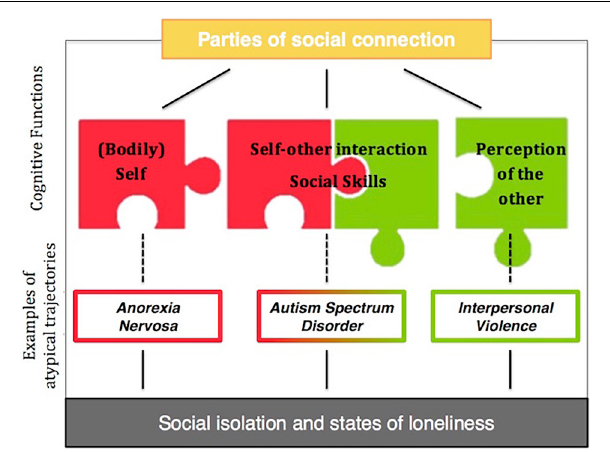
FIGURE 2 | Example cases of atypical connection with the self and the others which may be related to social isolation and states of loneliness. Anorexia Nervosa as a case of disconnection from the bodily self, Autism Spectrum Disorder as atypical self-other interaction and Interpersonal Violence as a result of disconnection from the